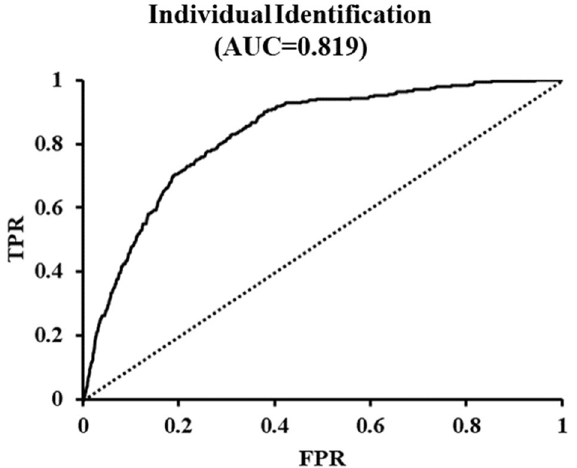
Figure 2. Receiver operating characteristic (ROC) curves of individual identification when new PPG data (353) measured from all subjects were compared with each individual reference data (#1 ~ #15).